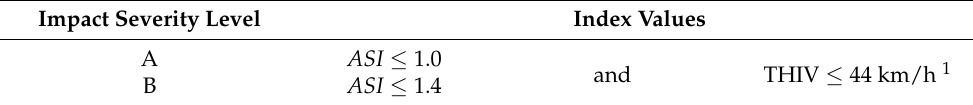
Table 5. Impact severity limits of crash cushions according to EN 1317-3